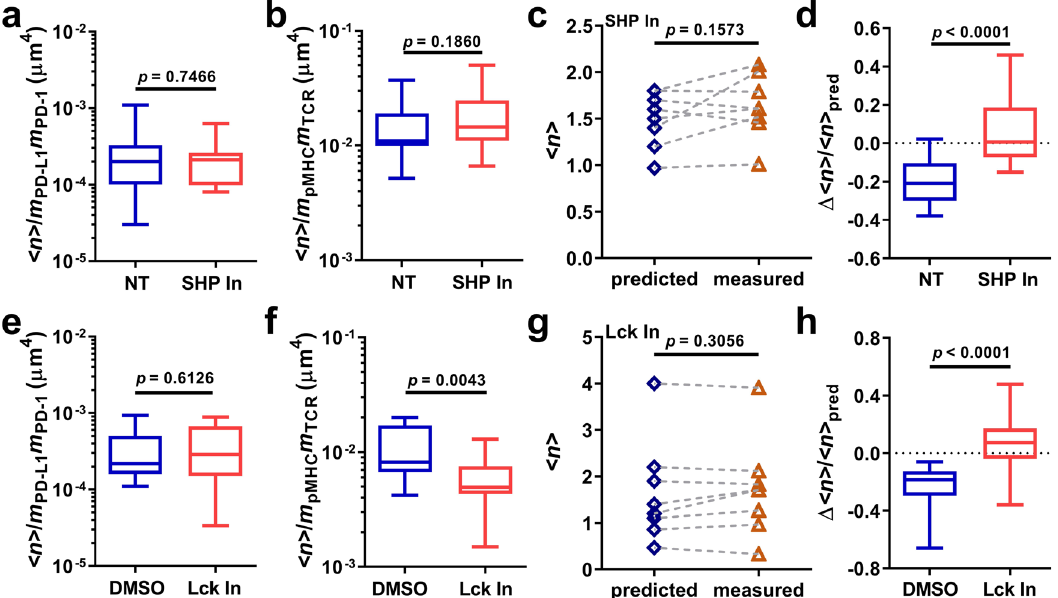
Fig. 3 Negative cooperativity depends on signaling of both PD-1 and TCR. a , b Comparisons of normalized numbers of single-ligand bonds formed between PD-L1 ( a , n = 42 and 14 cells) or pMHC ( b , n = 27 and 14 cells) coated RBCs and in vitro activated T cells that were not treated (NT) or treated with 20 µ M SHP1 and SHP2 inhibitor NSC87877 (SHP In). c Representative results comparing predicted and measured <n > ’ s determined from binding of NSC87822-treated T cells to RBCs bearing pMHC, PD-L1, or both. d Comparison of normalized bond reduction ( Δ < n > /<n > pred ) between the not treated and NSC87877-treated groups ( n = 17 and 14 cells). e – h Similar to a – d except that the not treated group was replaced by the DMSO group and NSC87877 was replaced by the Lck inhibitor (2 µ M). n = 14 and 15 cells in e . n = 14 and 16 cells in f . n = 14 and 16 cells in h . Data are presented by box-whisker plots with the center line labels median, the box contains the two middle quantiles, and the whiskers mark the min and the max. p values were calculated using paired t -test ( c , g ) or Mann – Whitney test (the